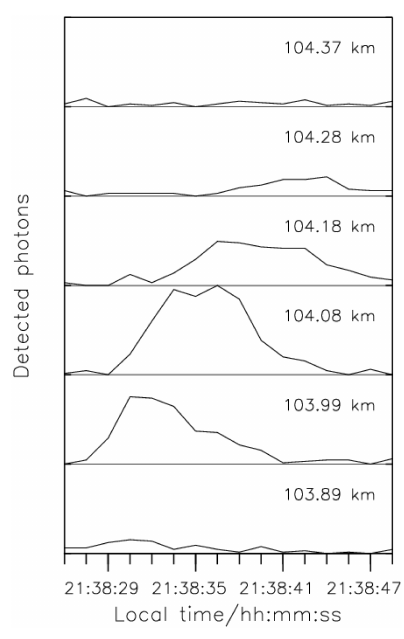
Figure 12. Temporal variation of the lidar returned signals at differ- ent altitudes, corresponding to Fig.